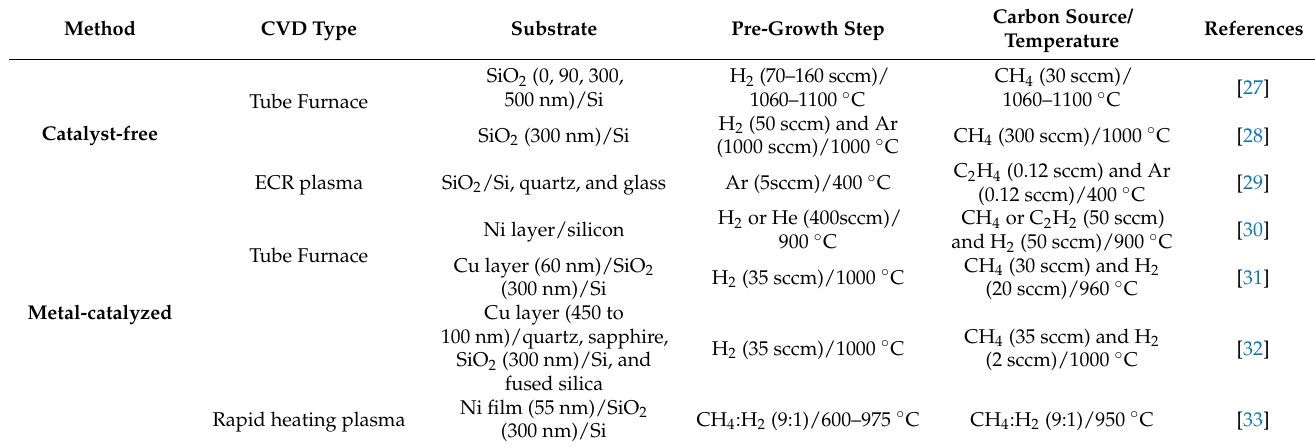
Table 1. Methodologies to grow graphene on non-metallic substrates by CVD. Some growth parame- ters such as gas flow, temperature and carbon source are